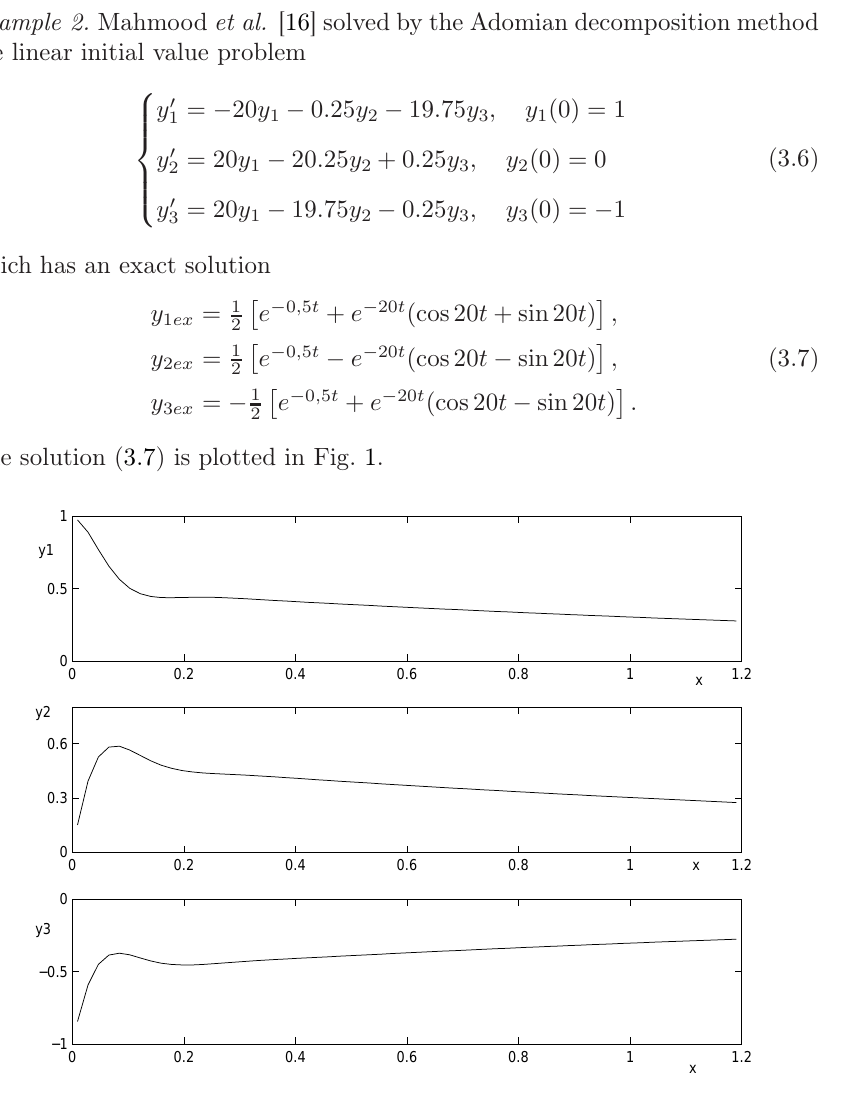
Figure 1. Solution of the system